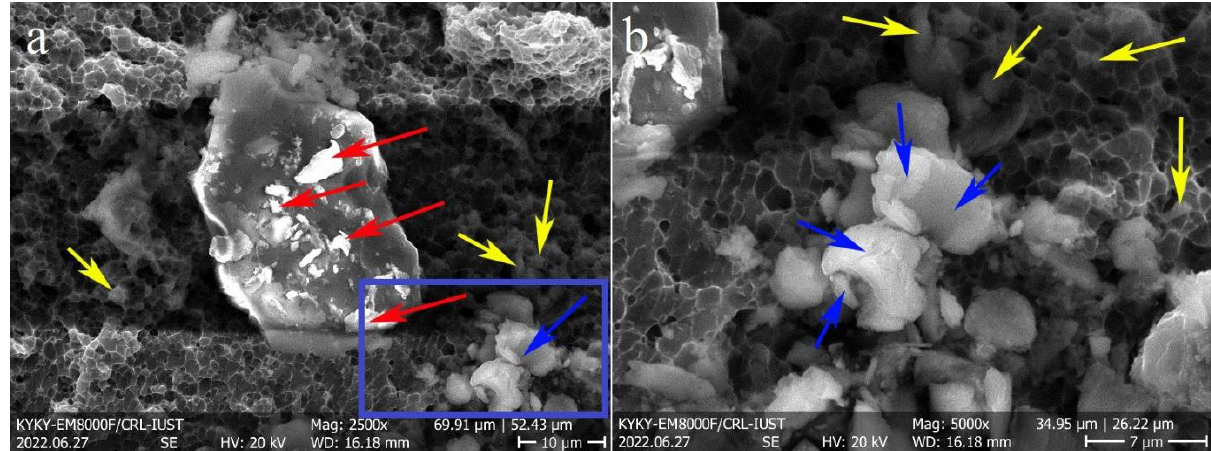
Figure 14. Secondary electron SEM images of the ( a ) fractured surface of FSPed samples, and ( b ) magnified view of the blue rectangle area in ( a ). The red, blue, and yellow arrows refer to the sticking of fine Si particles to the surface of a large one, coalescence of particles, and fine Si particles preset in dimples, respectively.